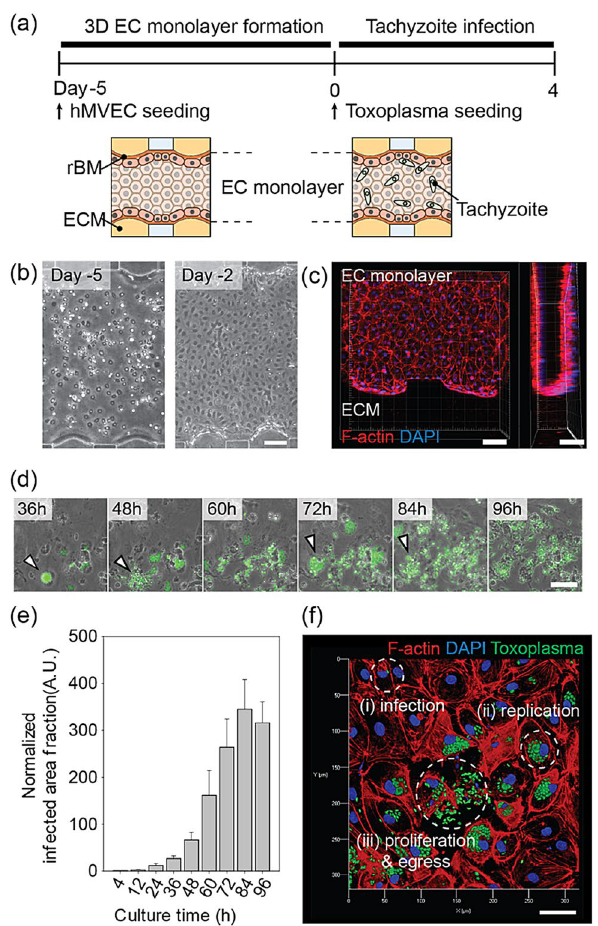
Figure 2. Tachyzoite infection model with a 3D EC monolayer in the microfluidic platform. ( a ) Time line of 3D EC monolayer formation and tachyzoite infection. ( b ) Phase images of EC monolayer at days 5 and 2. ( c ) Confocal image of the 3D EC monolayer on day 0 before seeding the tachyzoites. ( d ) Sequential phase images with 12 h intervals after the infection of tachyzoites. Infected cells indicated by arrowheads show the cycle, from duplication to egress. Scale bar indicates 100 µm. ( e ) Area fraction of tachyzoite in the EC monolayer and ECM region. (n = 8 for each group). ( f ) Overview of the tachyzoite cycle within the EC monolayer. Scale bar indicates 50 μm. Statistical significance was analyzed by one-way ANOVA with Holm-Sidak method ( e ) and is indicated by asterisks as follows: *P < 0.05, **P < 0.01, ***P <